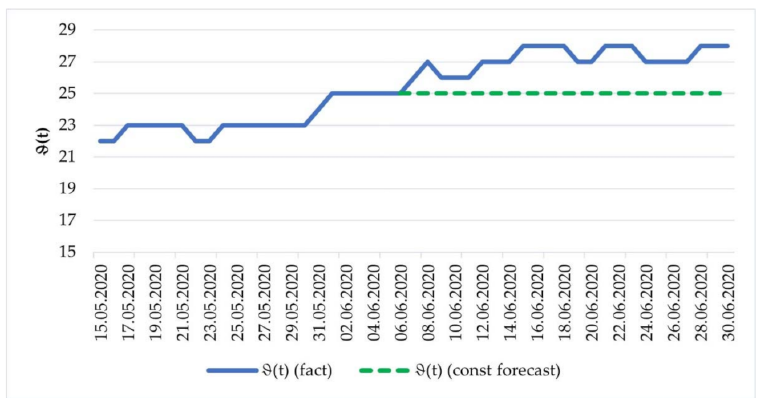
Figure 3. Actual and modeled values of the dynamic balance characteristic ϑ ( t ) from 15 May to 30 June 2022.